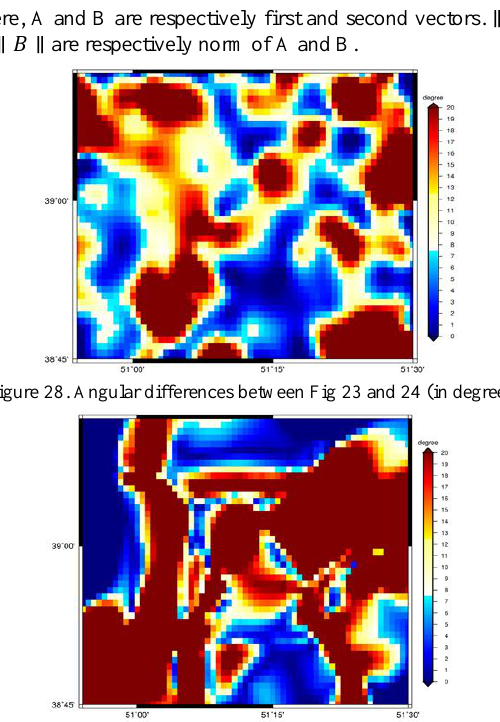
Where, A and B are respectively first and second vectors. ∥ 𝐴 ∥ and ∥ 𝐵 ∥ are respectively norm of A and B.